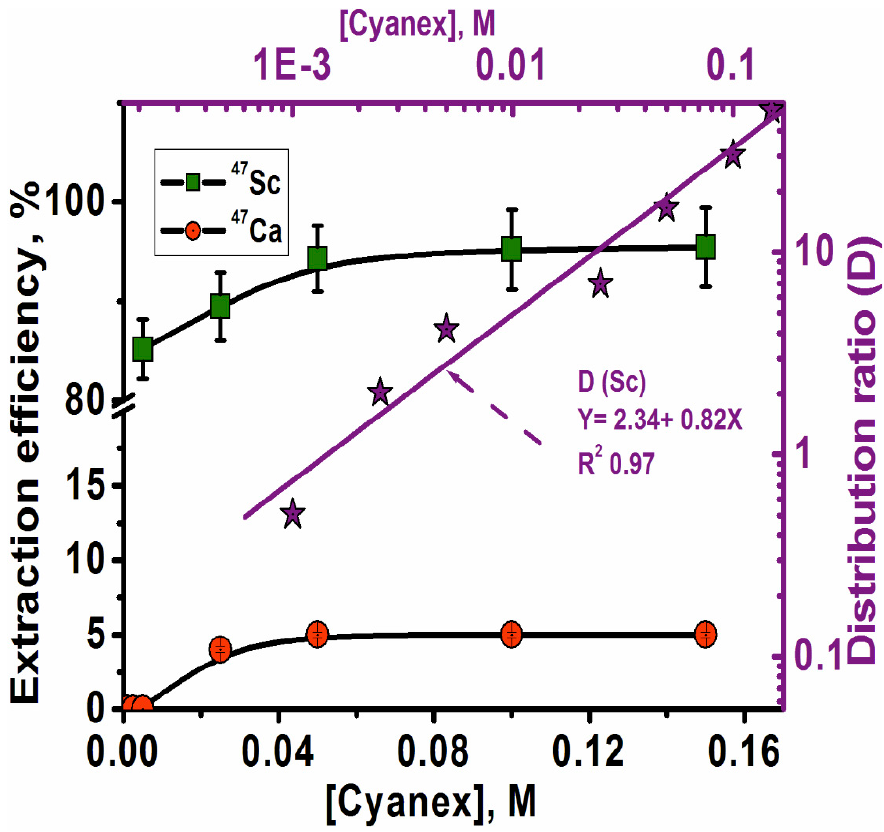
Figure 3. Effect of organic phase concentration on the extraction (%) and the distribution ratio values for the extraction of 47 Sc and 47 Ca at a 1:1 phase ratio, with an extraction time of 30 min, at pH 1.8 (0.015 M HCl) and 25 ± 1 °C.